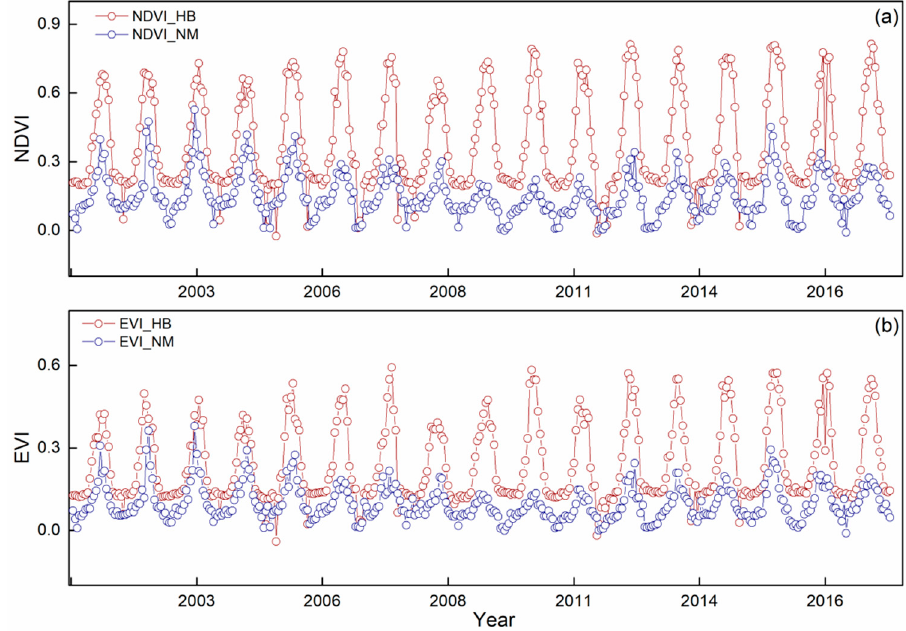
Figure 4. Seasonal ( a ) and interannual dynamics ( b ) of MODIS vegetation index (NDVI and EVI) in Haibei (HB) and Inner Mongolia (NM) grassland stations from 2001 to 2017.